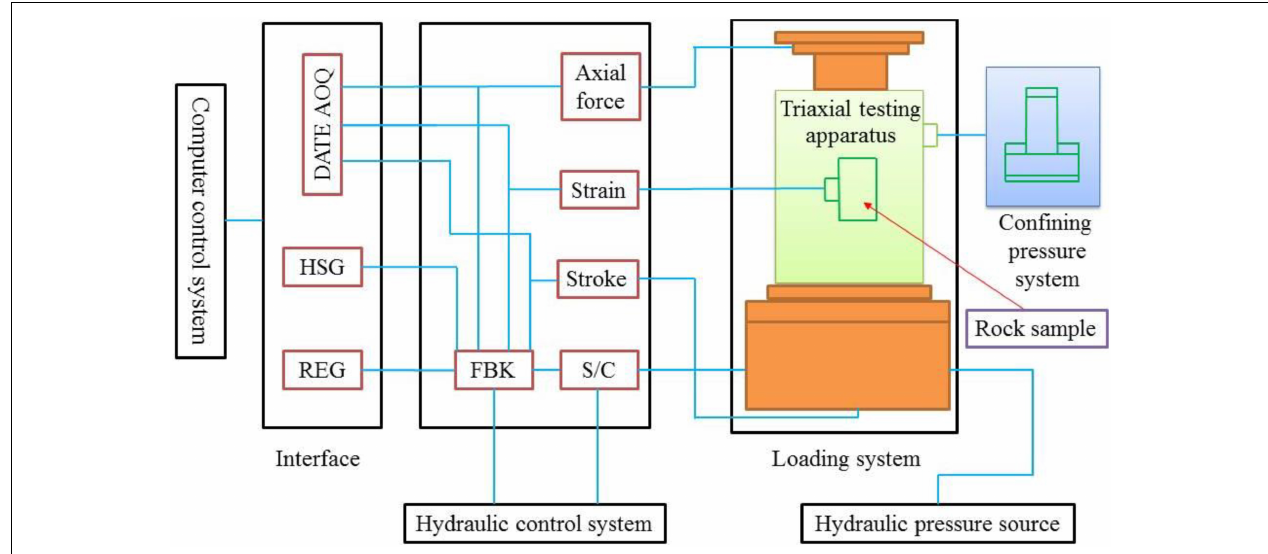
FIGURE 1 | Schematic of the deformation test